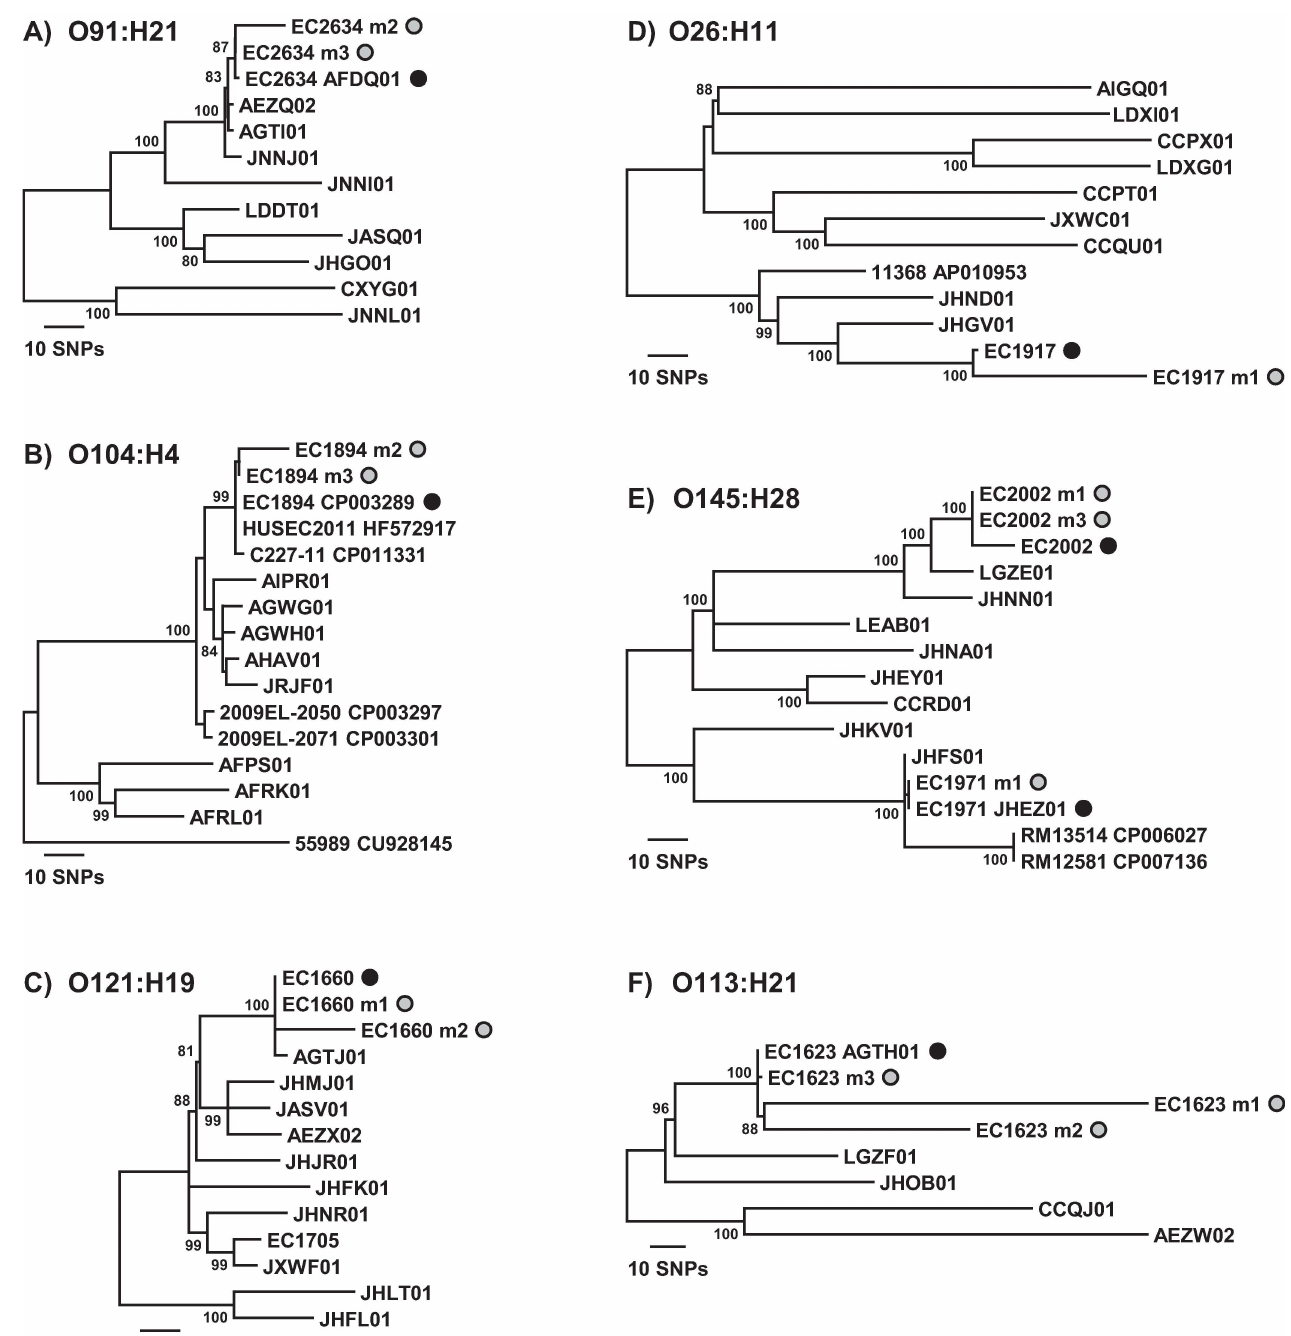
Fig 4. Finer-scale resolution of the phylogenetic relationships resulting from E . coli core gene SNP analysis. Neighbor-joining trees for the O91:H21, O104:H4, O121:H19, O26:H11, O145:H28, and O113:H21 clonal groupswere constructed using a p distancematrix and 500 bootstrap replications. The spiked STEC strains and metagenomic samples are indicatedby the black and gray circles, respectively. Bootstrap values > 80% are given at the